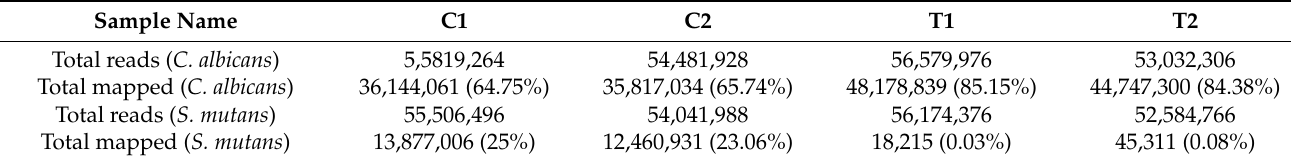
Table 1. RNA-seq in mixed-species biofilms.